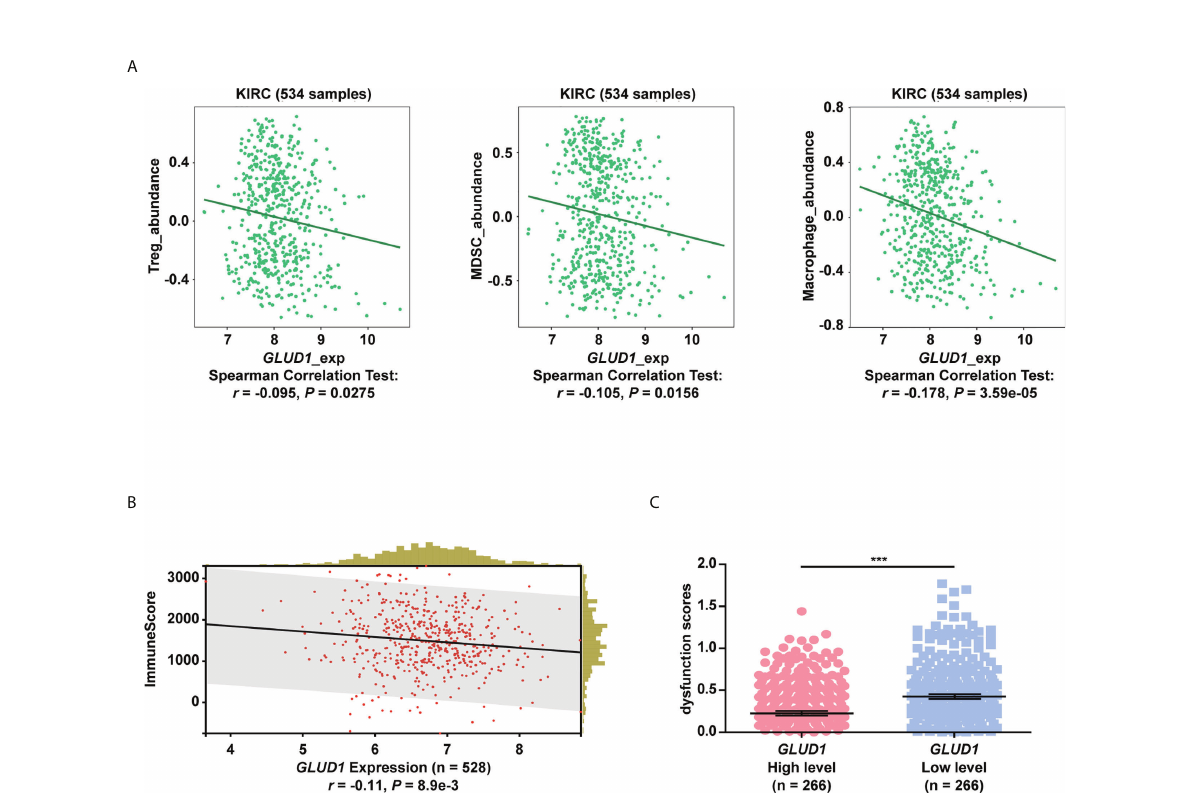
FIGURE 6 GLUD1 level is negatively associated with the ccRCC immunosuppressive microenvironment. (A) Correlation between GLUD1 level and immunosuppressive cell in fi ltration score in ccRCC patients. (B) Correlation of GLUD1 with immune cell in fi ltration in ccRCC. (C) The correlation between GLUD1 level and T cell dysfunction score by TIDE analysis. *** P <